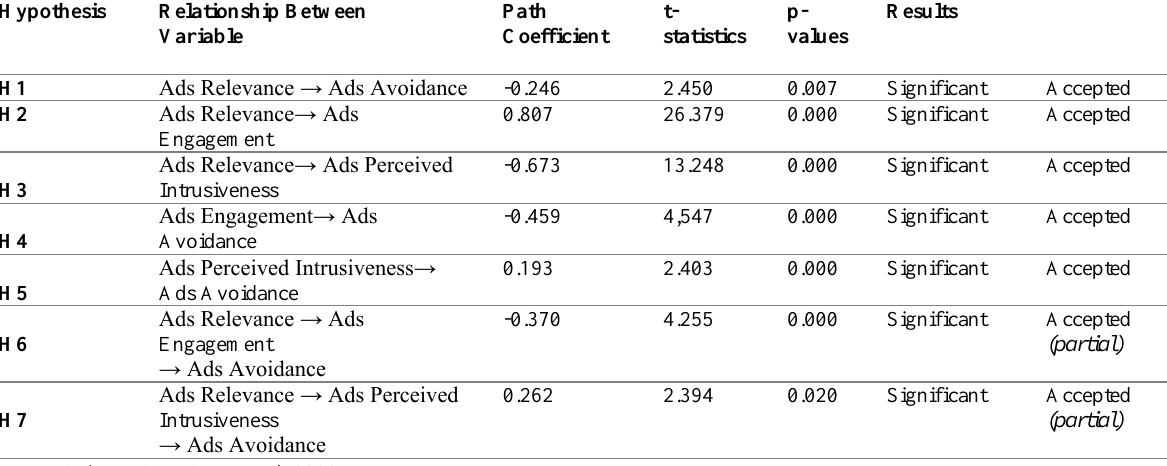
Table 2 : Hypothesis Testing